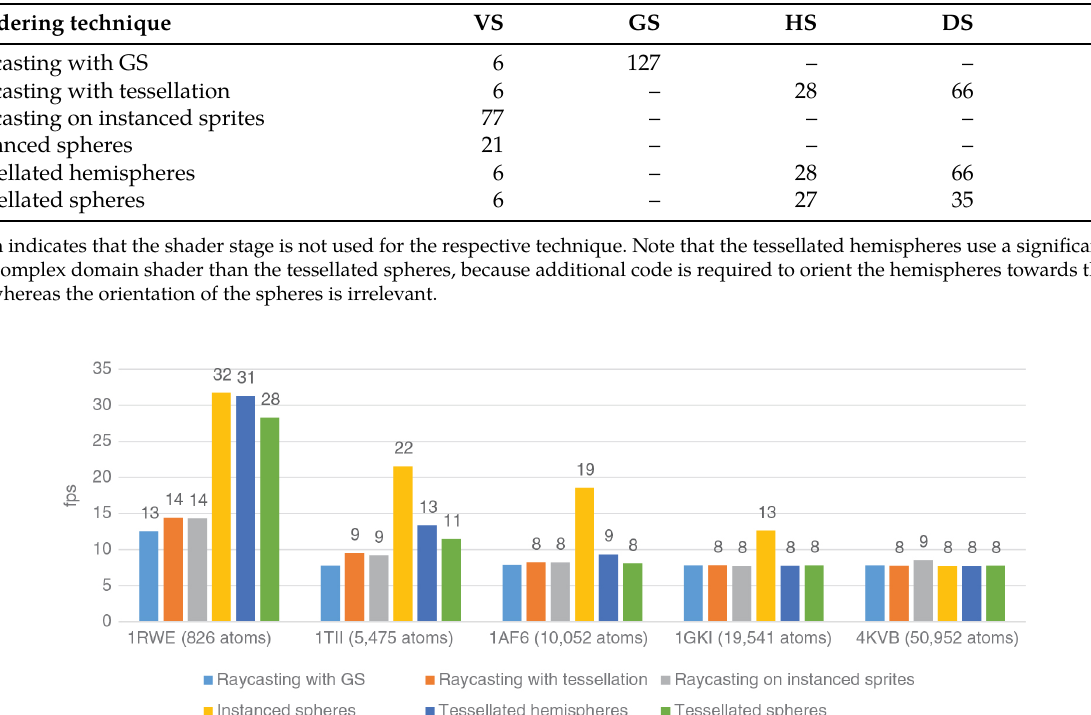
Table 2: Approximate number of assembler instructions as reported by the HLSL compiler for the vertex shader (VS),